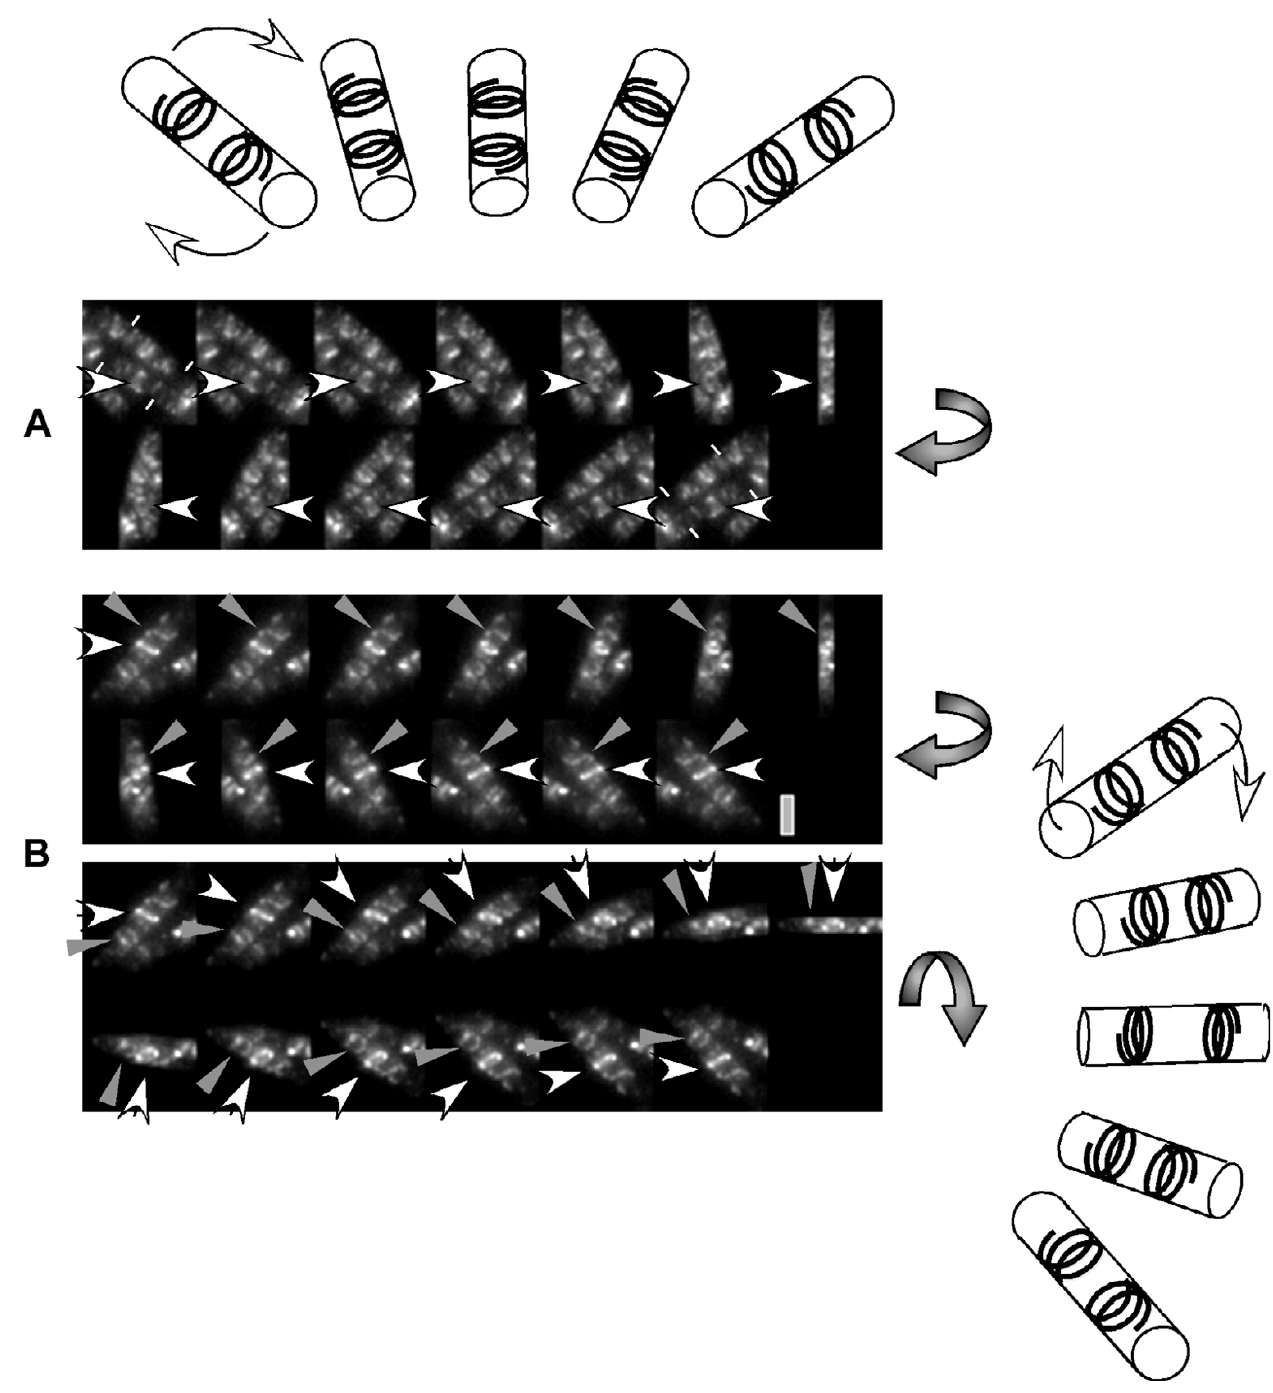
Figure 4 3D reconstruction of stacks of Z sections taken through B. subtilis cells expressing MreB-GFP. 180° view of cells (panels are tilted 15° relative to each other as indicated by the grey arrows next to the panels). A) Horizontally turned view of two cells (ends are indicated by white lines, arrow indicates clearly visible helical filament), B) horizontal (upper panel) and vertical (lower panel) view on a single cell (white arrow indicates helical filament, grey arrow half turn filament). The cartoons indicate the rotation, the cartoon on top for the first two panels, the cartoon on the right for the third panel. All images are scaled identically, grey bar 2 µ